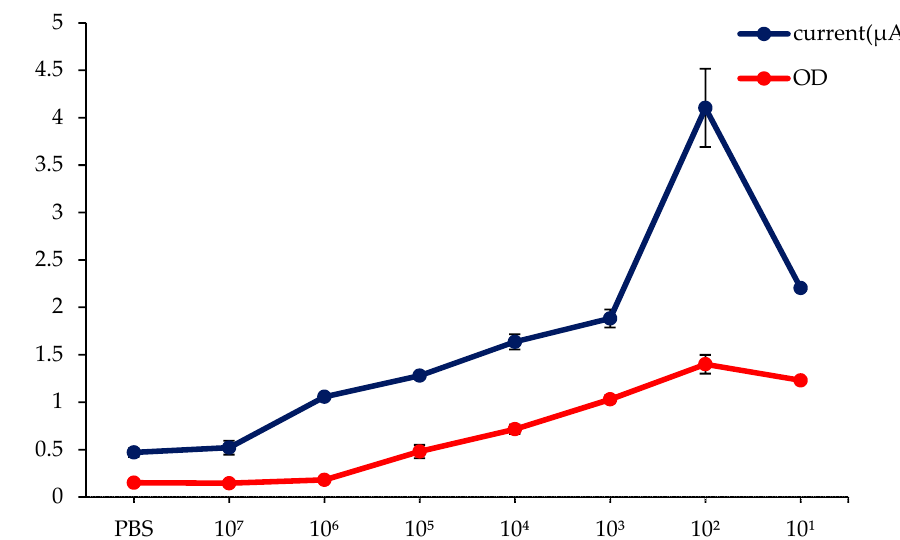
Figure 5. Comparative analysis of the analytical sensitivity of the dengue IgM biosensor against commercial dengue IgM ELISA. NC: negative control (consisting of a dengue IgM negative serum pool). PBS was used as diluent for the serum.